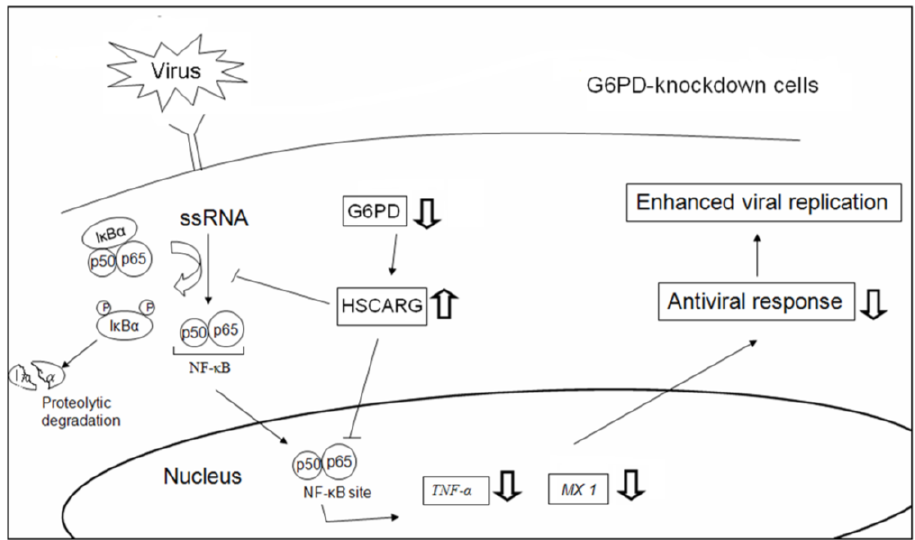
Figure 8. A schematic diagram shows how G6PD enhances antiviral response. In normal cells, viral infection induces IκB degradation and NF-κB translocation, which promote antiviral response and inhibit virus replication. In G6PD -knockdown cells, the fall in NADPH/NADP + ratio leads to HSCARG upregulation, which negatively affect NF-κB signaling and antiviral gene expression in response to viral infection. In this manner, viral replication is enhanced. An upward arrow indicates increase in expression or response, while a downward arrow indicates decrease in expression or response.